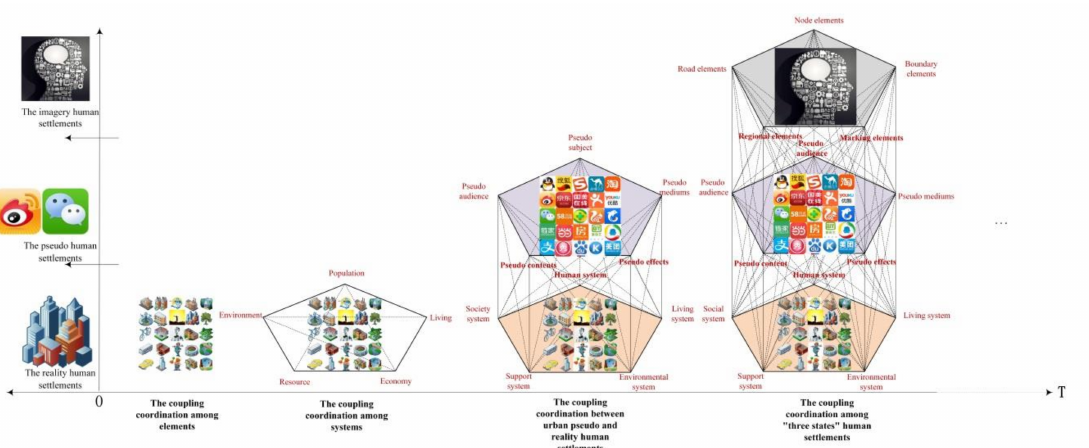
Figure 1. The dynamic frame diagram of coupling relationship among “three states” human